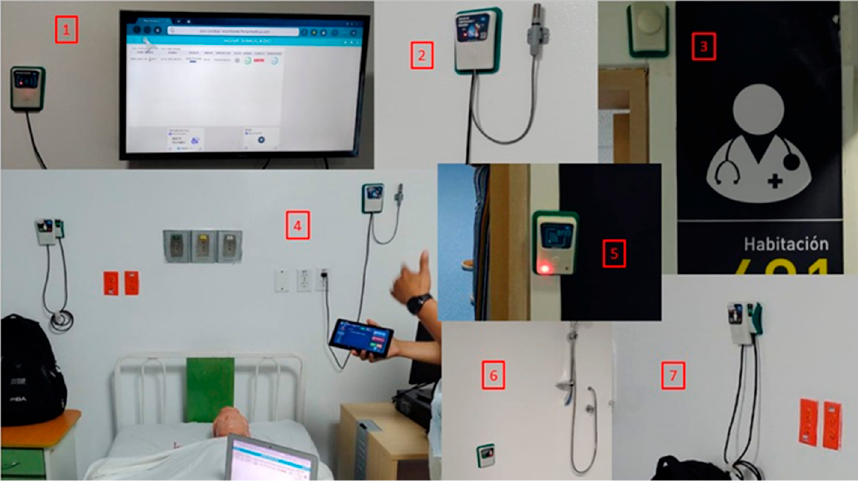
Figure 12. IoT-based nurse call system. 1. Central gateway and Smart TV in central monitoring 2. Temperature, humidity, and comfort sensor 3. Corridor light 4. data display from Tablet 5. RFID sensor 6. toilet button 7. multifunctional patient call button.